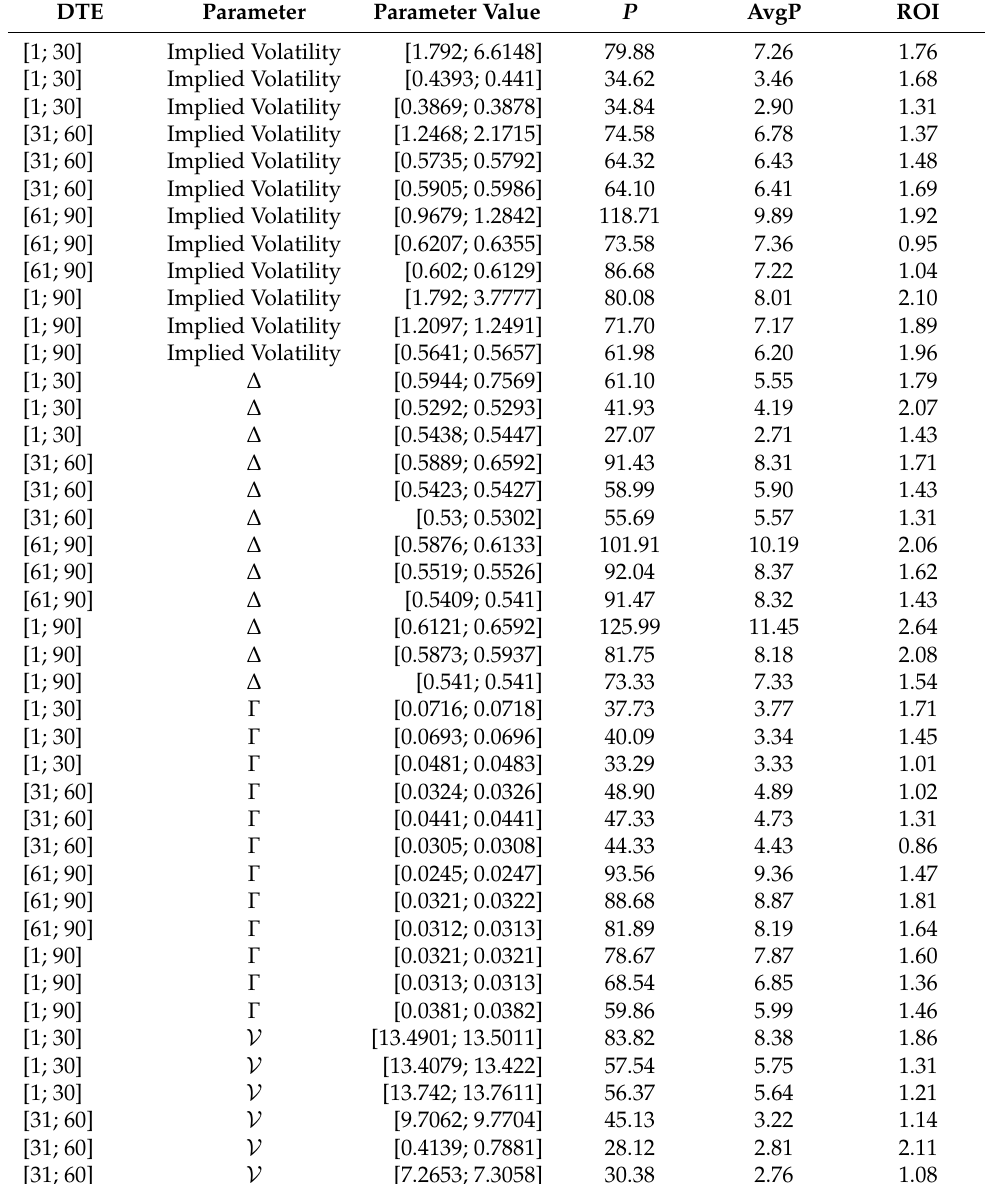
Table A2. Warto´sci wska´zników P, AvgP i ROI dla najlepszych reguł uzyskanych ze wzgl˛edu